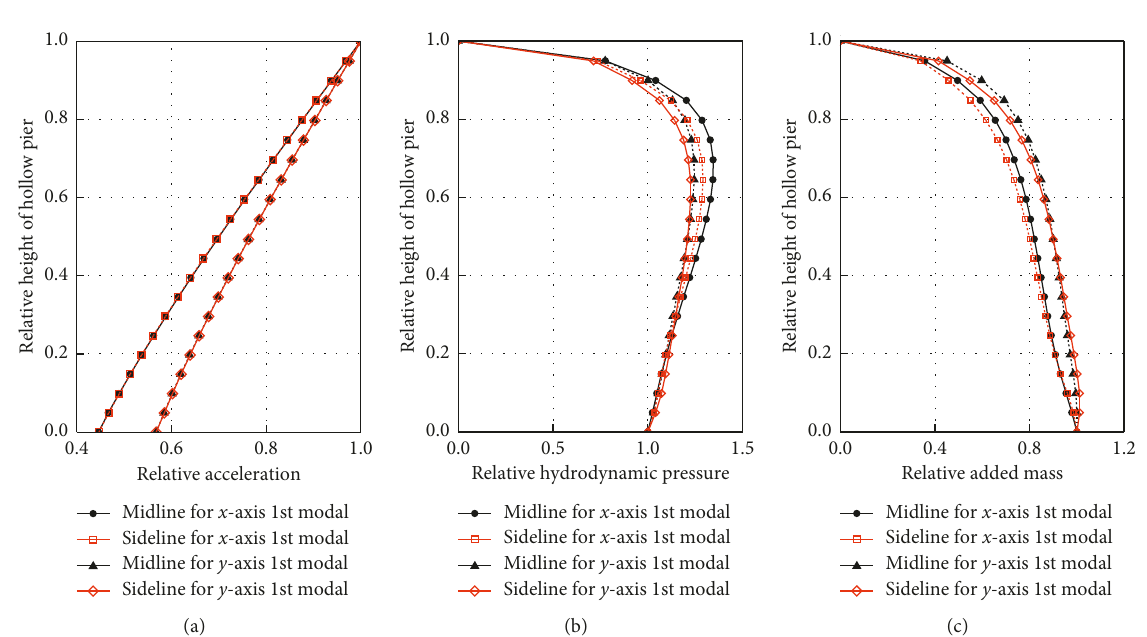
Figure 13: Distribution of relative modal acceleration, relative hydrodynamic pressure, and relative HAM along the specimen without tip mass corresponding to a water level of H w � 1.8m in case I: (a) relative modal acceleration; (b) relative hydrodynamic pressure; (c) relative